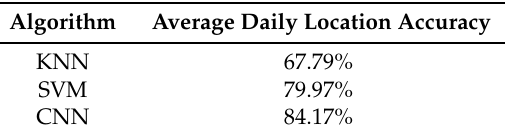
Figure 12. Comparison between experiment results with different algorithms. Table 9. Average daily location